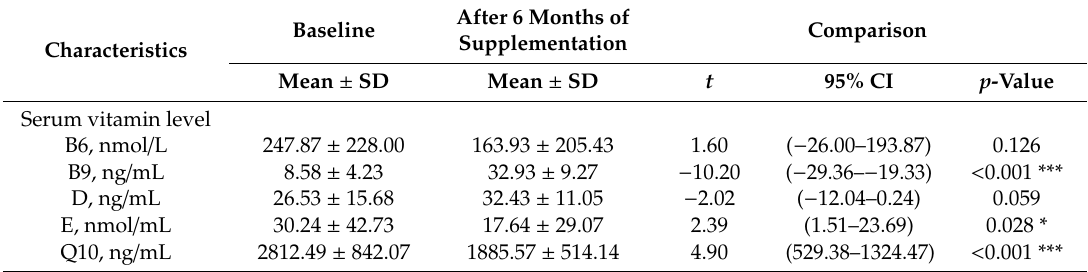
Data are presented as mean ± SD or number (percentage). AED, antiepileptic drug; B6, pyridoxal 5 (cid:48) -phosphate (PLP); B9, total folate; D, total 25 hydroxyvitamin D; E, total human vitamin E; Q10, total coenzyme Q10. * p < 0.05, *** p <